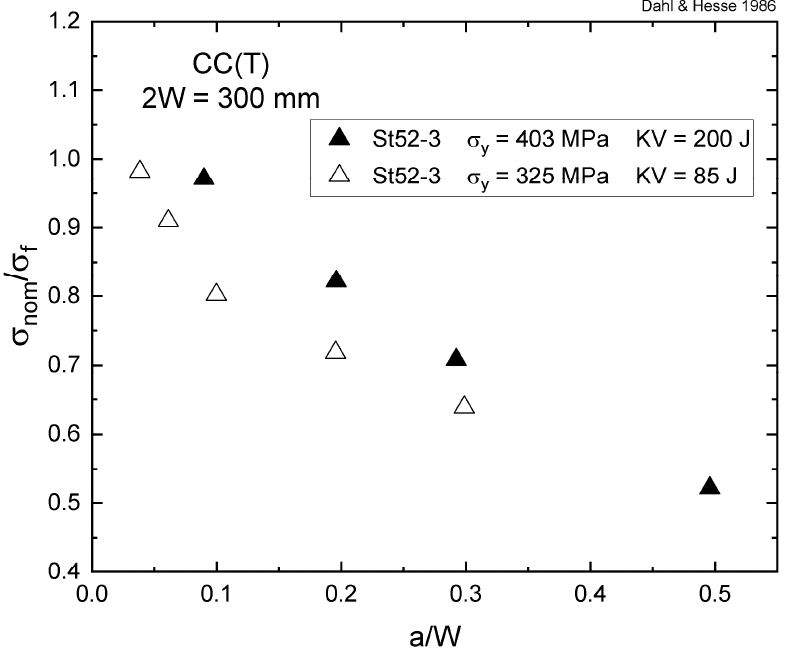
Figure 8. CC(T) test maximum load (nominal stress) values divided by flow stress for two different St52-3 steels, as a function of relative crack length a/W [9].